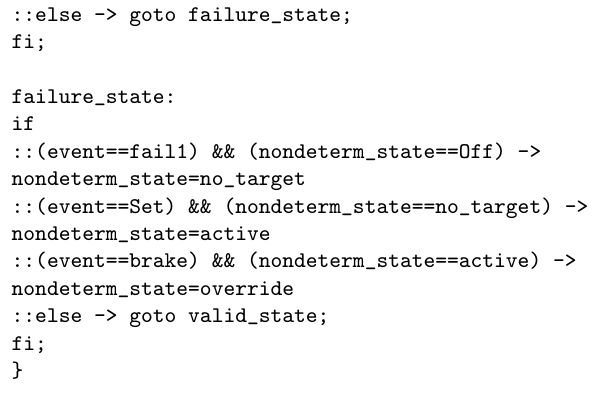
Fig. 9. P ROMELA specification for nondeterministic behav-